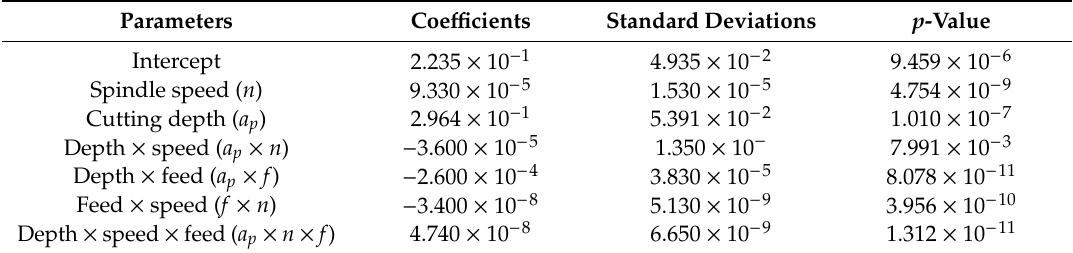
Table 1. Regression parameters for surface roughness prediction model.